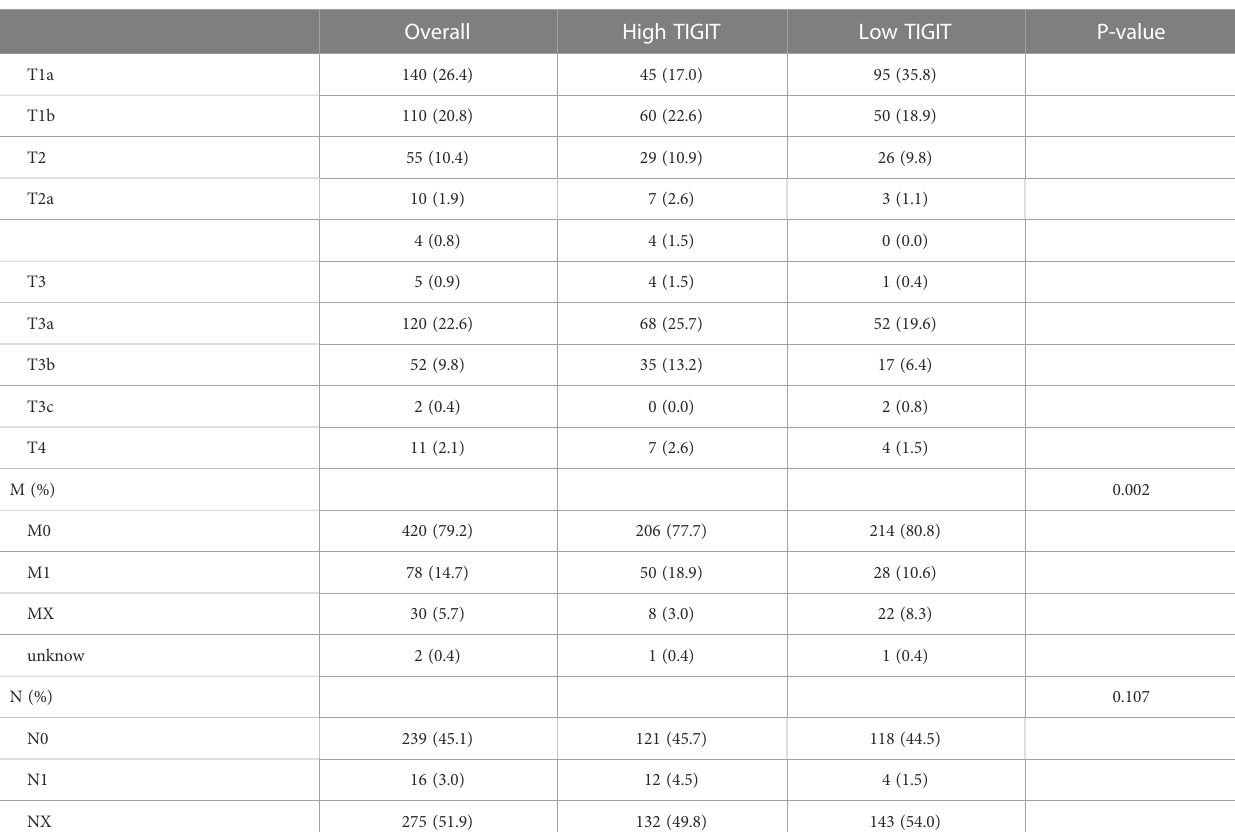
various cancers (Figure 2D). And the fi rst three organs with the highest expression of TIGIT were the spleen, blood, and small intestine. The lowest three were pancreas, skeletal muscle, and bone marrow, and TIGIT showed a moderate expression in normal kidney (Figure 3A). Interestingly, the expression of TIGIT in females ’ brains, lungs, breasts, and small intestine was signi fi cantly higher than that in males (Figure 3B). TIGIT was the highest expression in the spleen in males and females (Figures 3C, D). Here we focused on the kidney and discovered a higher expression of TIGIT in kidney tumor with a mean expression of 0.24 in normal kidney and that of 1.47 in kidney tumor (Figure